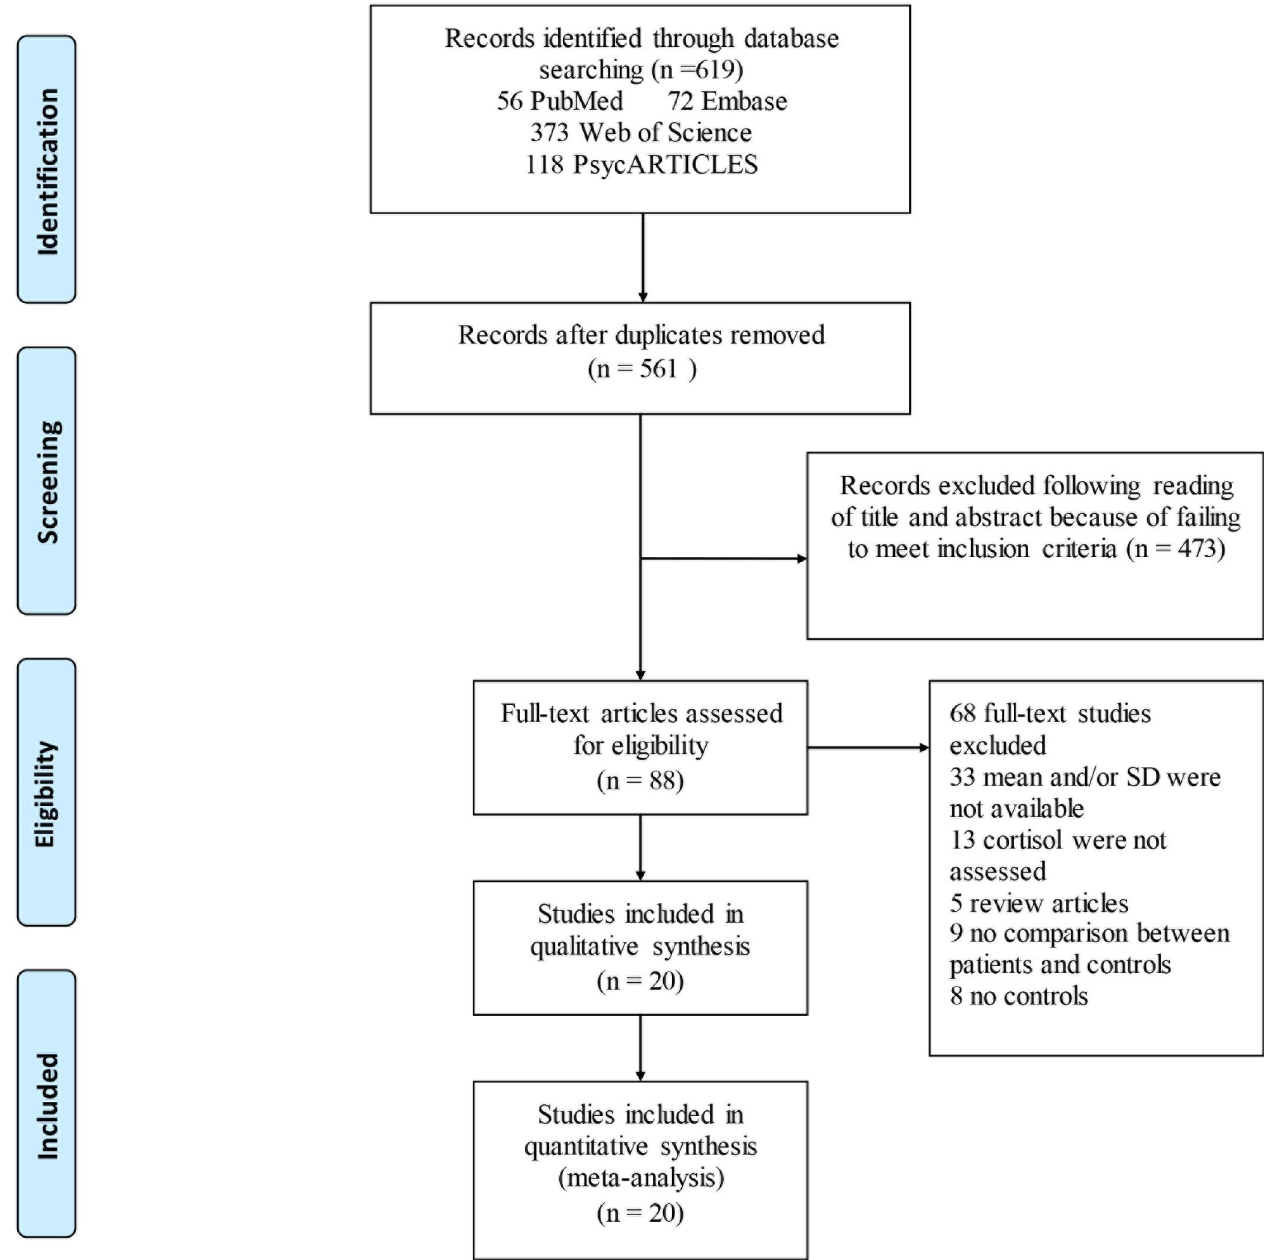
Fig 1. Flow chart of study selection. Showing the process by which relevant studies were retrieved from the databases, assessed, and selected, or excluded. Preferred reporting items for systematic reviews and meta-analyses (PRISMA) diagram for study search.